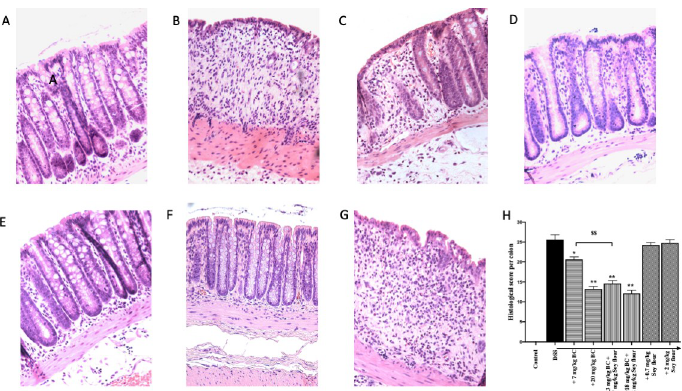
Fig 4. Influence of BC alone, soy flour alone or the combination on DSS-induced histological colonic injury in rats. Same rats as Fig 4. (A) Normal (no DSS), showing normal crypt structures (B) DSS alone, showing complete loss of crypt architecture and increased inflammatory infiltrate (C) DSS + BC (7 mg/kg), (D) DSS + BC (20 mg/kg), (E) DSS + BC (6.3 mg/kg) + soy flour (0.7 mg/kg), (F) DSS + BC (18 mg/kg) + soy flour (2 mg/kg), (G) DSS + soy flour alone (2 mg/kg), (H) Histological scores of rat colons using method described in [14].